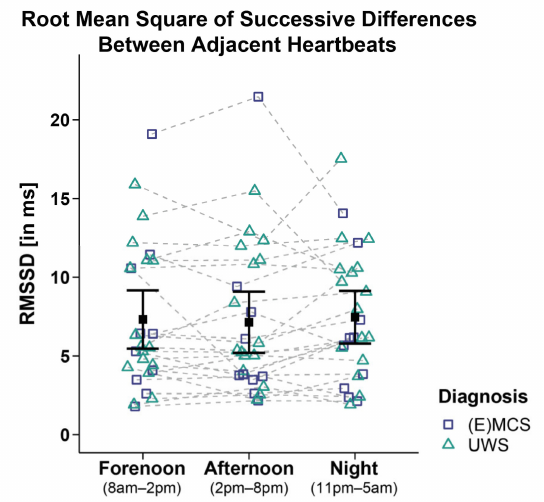
Figure 3. Root mean square of successive differences between adjacent heartbeats (RMSSD). Patients’ RMSSD did not differ between time ranges and diagnoses. Error bars represent the mean and 95% confidence interval. Abbreviations: (E)MCS = (emergence from) minimally conscious state; UWS = unresponsive wakefulness syndrome; ms =